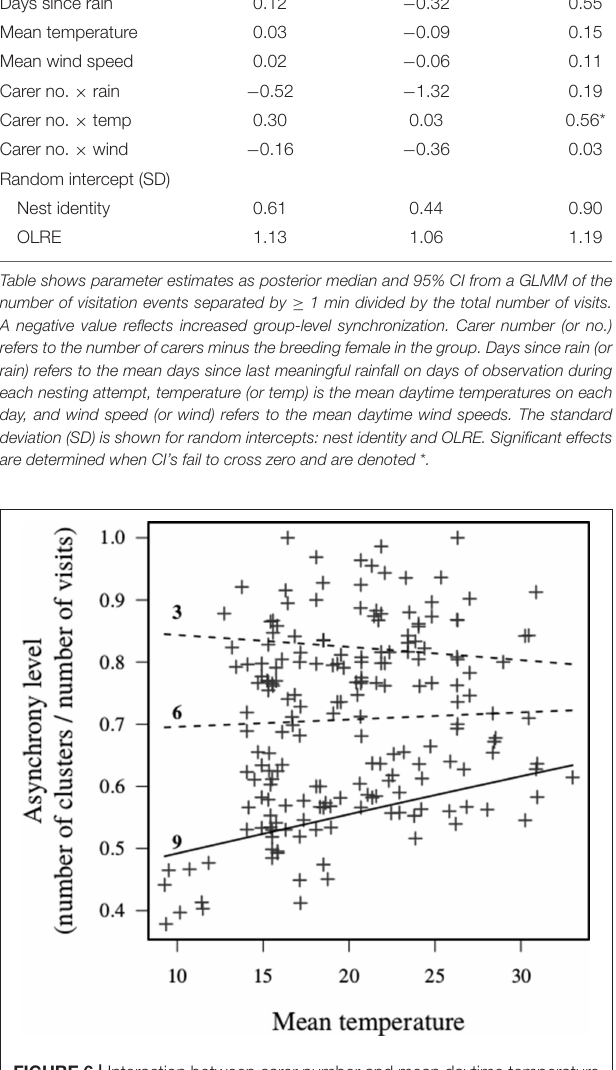
FIGURE 6 | Interaction between carer number and mean daytime temperature on group-level synchrony. The numbers in the figures indicate the number of carers excluding the breeding female. Lines show predicted means for each value of the carer number. Solid line indicates that 95% CI of the slope estimate did not include zero, and dashed line indicates that it included zero. Only large units (e.g., 9 + carers) increased asynchrony with increased daily temperature, whilst smaller units showed no clear